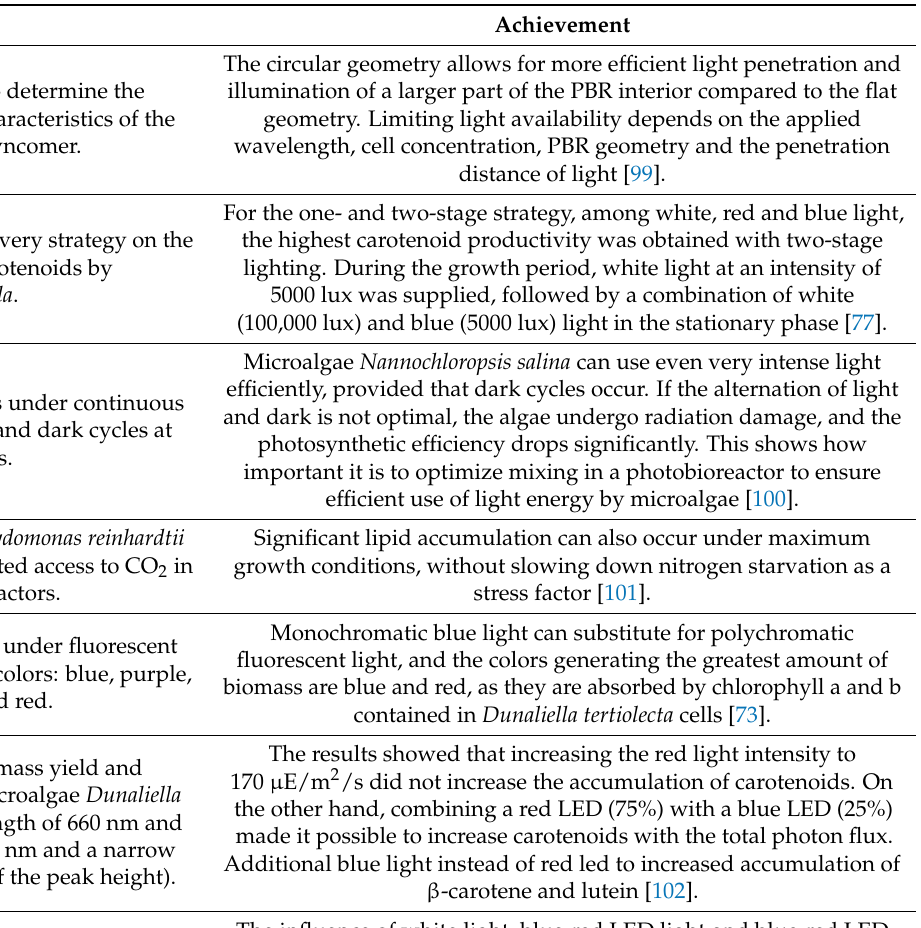
Table 9. The effect of light on microalgal growth in